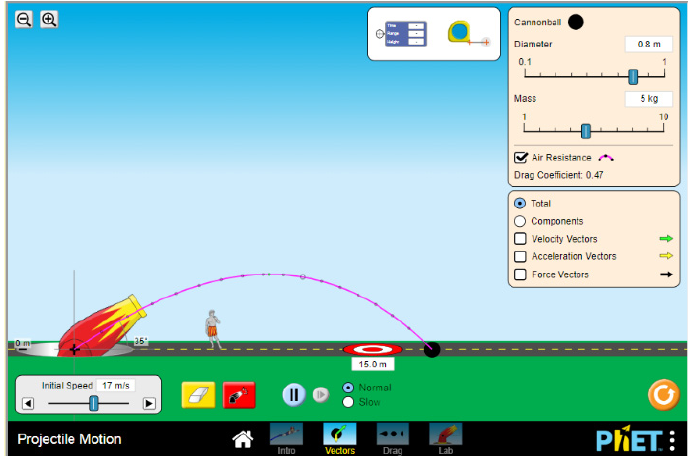
Figure 2. Screenshot Projectile Motion—PHET.